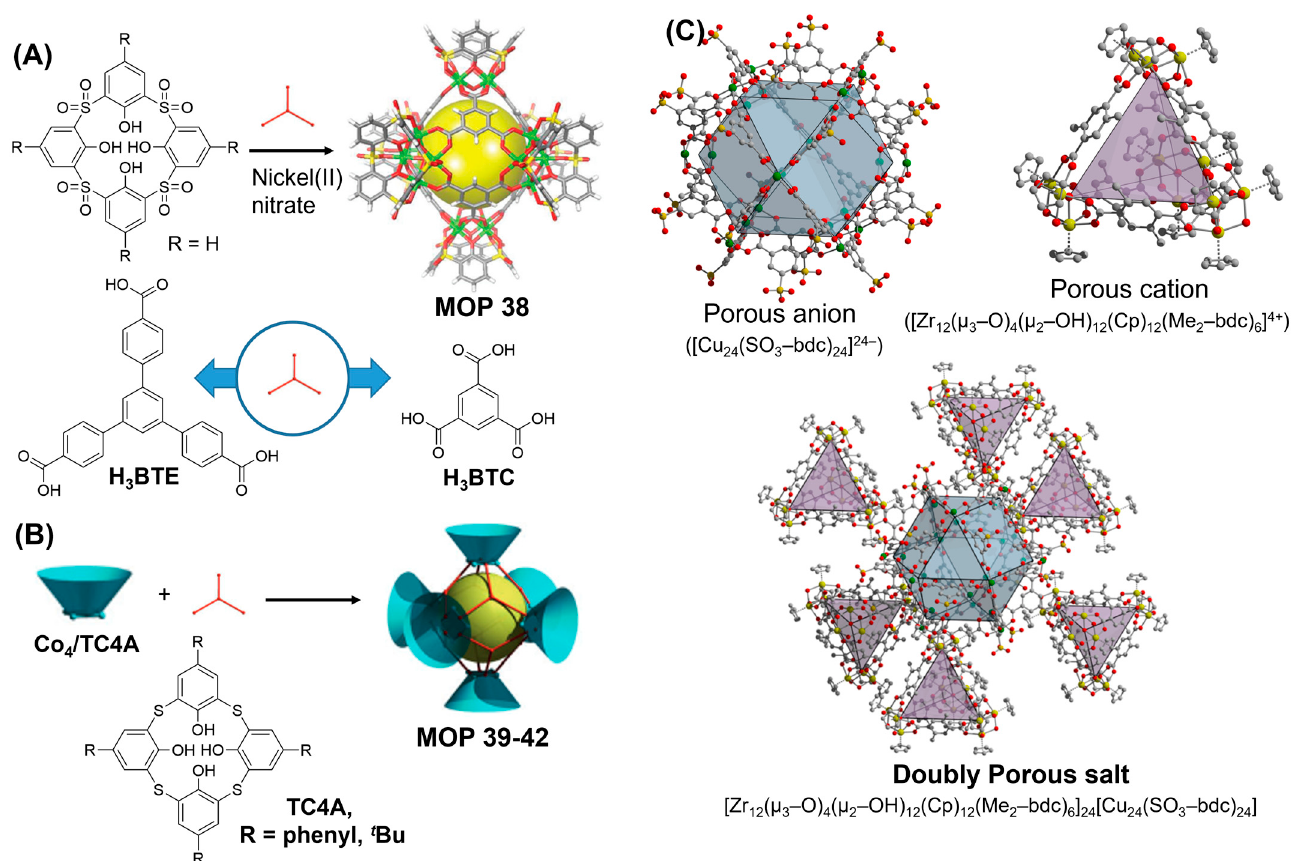
Figure 15. ( A ) Design principle for the assembly of virus-like metal-organic supercontainers via binding of tetranuclear p -tert-butylsulfonylcalix-[4]arene complex with H 3 BTE and H 3 BTC. ( B ) The nanocoordination octahedra formed by Co 4 /TC4A shuttlecock-like SBUs and tritopic linkers, where TC4A may be p-tert-butylthiacalix[4]arene/p-phenylthiacalix[4]arene. Copyright 2009 Wiley-VCH Verlag GmbH & Co. KGaA, Weinheim for ([Co 4 (TC4A)Cl] 6 (BTC/BTB) 8 ) 6 − . ( C ) Charged MOPs used for the preparation of a doubly porous salt where the charge-balancing cations for the cuboctahe- dron MOP [Cu 24 (SO 3 -bdc) 24 ] 24 − and anions for the tetrahedron MOP [Zr 12 ( μ 3 -O) 4 ( μ 2 -OH) 12 (Cp) 12 (Me 2 -bdc) 6 ] 4+ . A portion of the crystal structure of the doubly porous salt [Zr 12 ( μ 3 -O) 4 ( μ 2 -OH) 12 (Cp) 12 (Me 2 -bdc) 6 ] 2 [Cu 24 (SO 3 -bdc) 24 ]. Reprinted by permission from Refs. [139,145–147]. Copyright 2012 and 2020